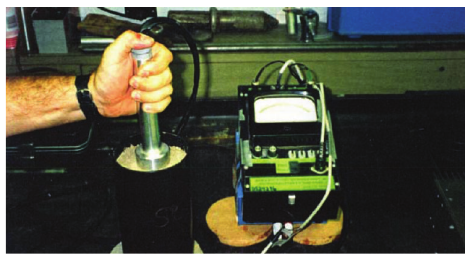
Figure 5: Adek percometer surface dielectric probe equipment.